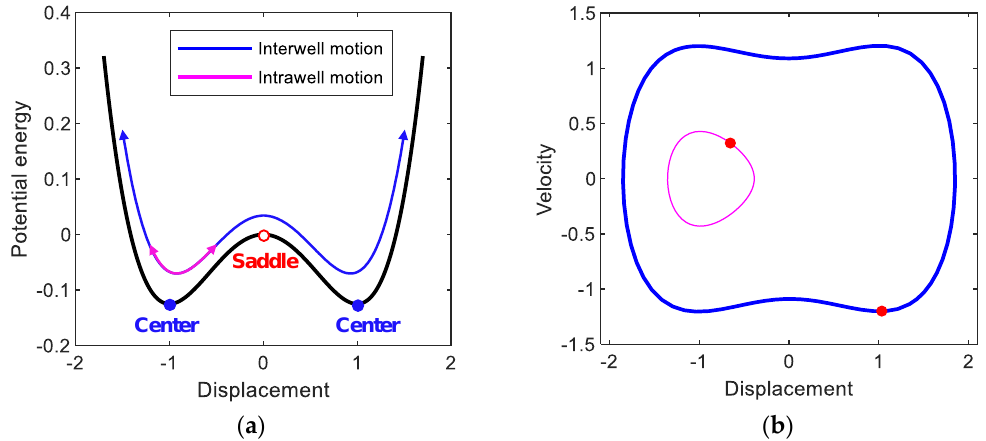
Figure 2. ( a ) Double-well potential energy function of the electromagnetic bi-stable energy harvester. The open and solid circles indicate the saddle and center points, respectively. ( b ) Phase plane representation of the intrawell and interwell oscillations (of period T = 2 π / ω ), which are denoted by thick (blue) and thin (magenta) lines, respectively, obtained when A = 0.02 and ω = 0.82. In ( b ), the red points indicate the stroboscopic projections of the oscillations, which are synchronized with the period T of the base